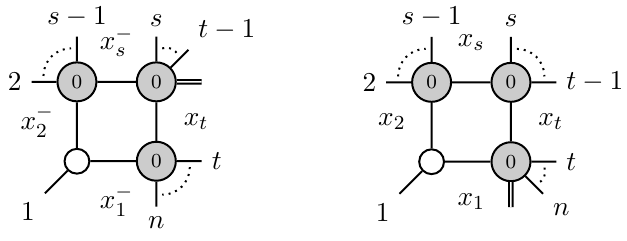
Figure 1 . Examples of region variables assignment for two R -invariants. We label region momenta starting from the region adjacent to the corner containing the o(cid:11)-shell leg in clockwise